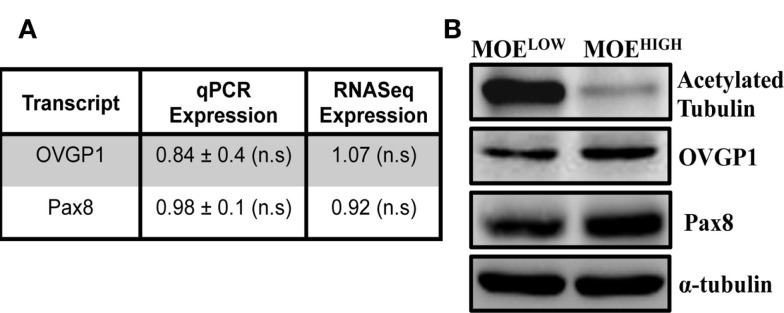
MOEHIGH lose acetylated tubulin upon serial passaging. (A) OVGP-1 and Pax8 expression levels were similar in qPCR and RNA sequencing and not significant (n.s.) between MOEHIGH and MOELOW. (B) Western blotting on MOEHIGH and MOELOW cell lysates probed for acetylated tubulin, OVGP-1, PAX8, and normalized to α-tubulin.